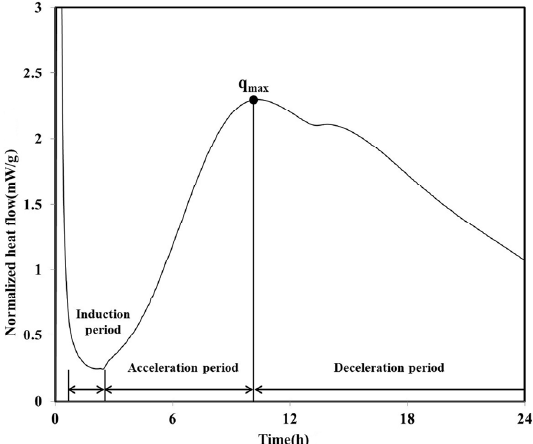
Figure 2. Normalized heat flow during initial 24 h of hydration (LH100).